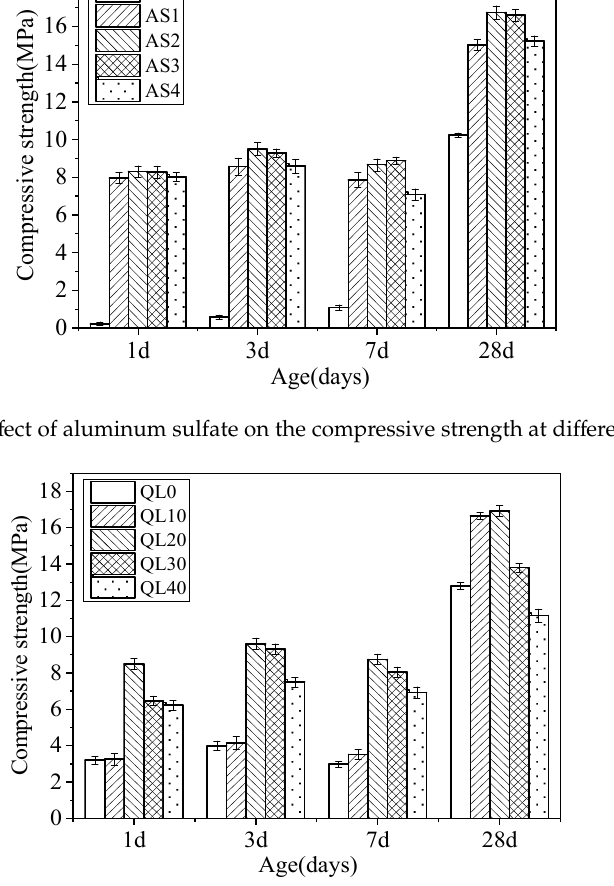
Figure 4. Effect of quicklime on the compressive strength at different ages.